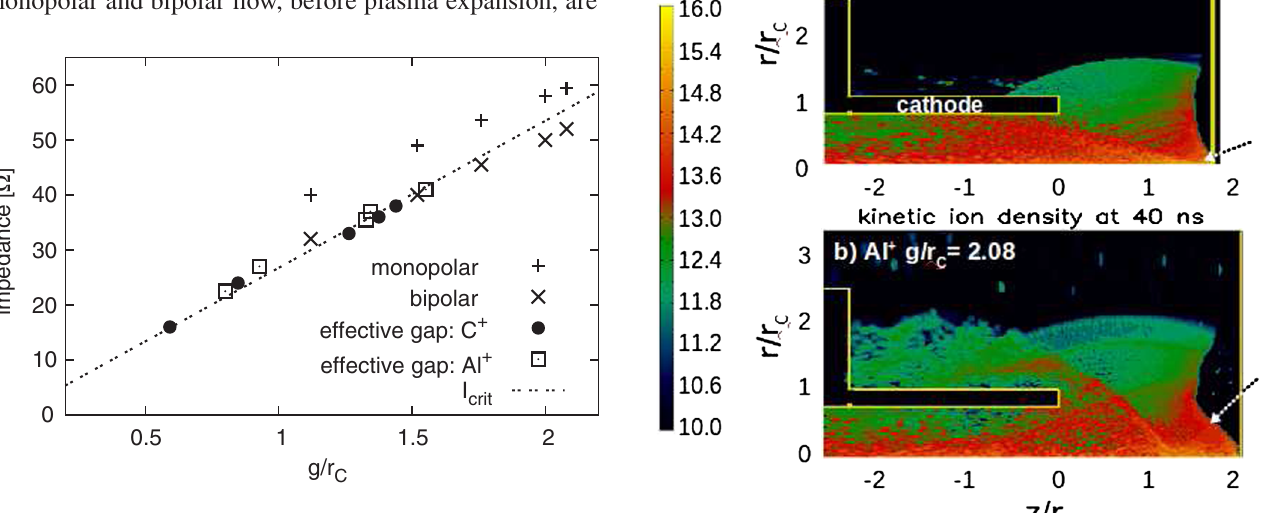
FIG. 6. The SMP diode impedance as a function of g=r ‘‘Monopolar’’ refers to that portion of the pulse during which only an electron current is present. ‘‘Bipolar’’ refers to counter- streaming electrons and ions. ‘‘Effective-gap’’ measurements are made at 44 and 52 ns into the simulation, after the anode plasma has extended into the A-K gap and changed the location of the potential maximum. The effective gap is shown separately for C þ and Al þ species anode plasmas. The ‘‘ I calculated from Eq. (1) for (cid:1) ¼ 2 : 2 and V ¼ 7 : 5 MV .